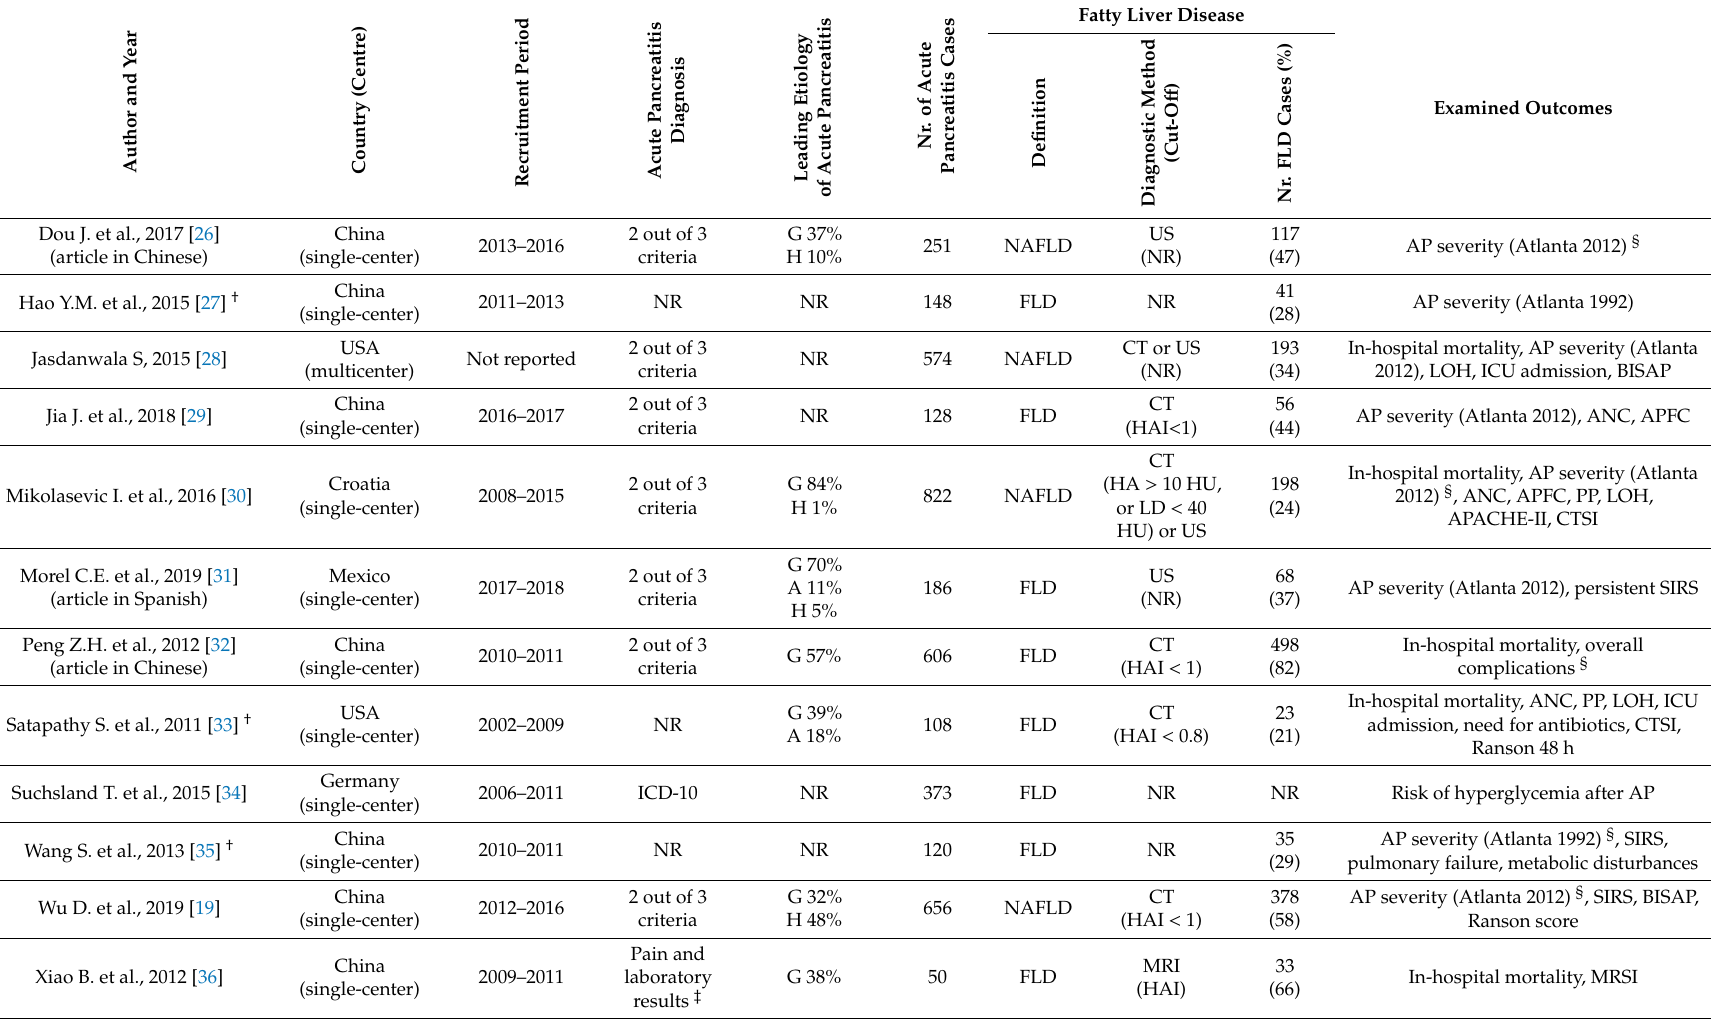
Table 1. Characteristics of the studies included in the systematic review and